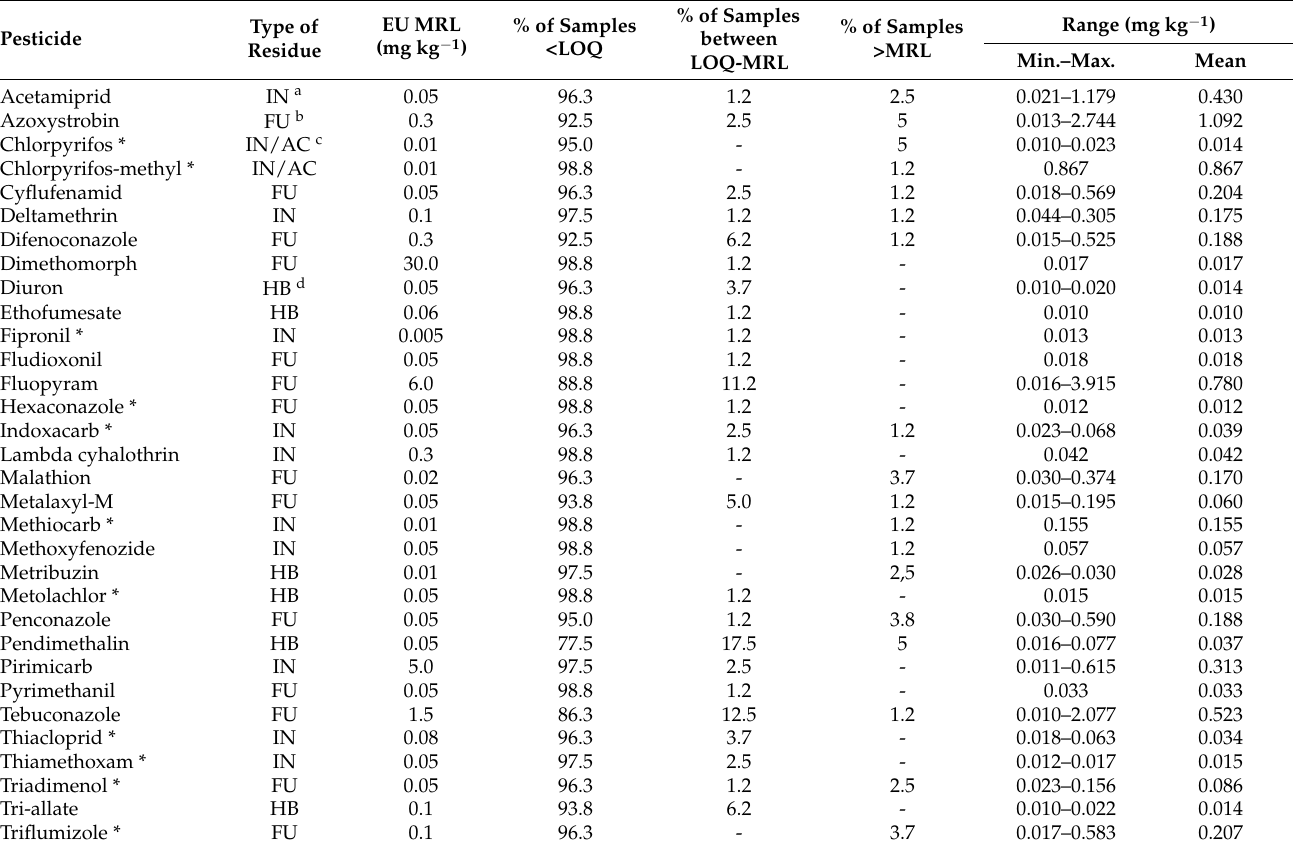
Table 2. The presence and quantification of pesticide residues in